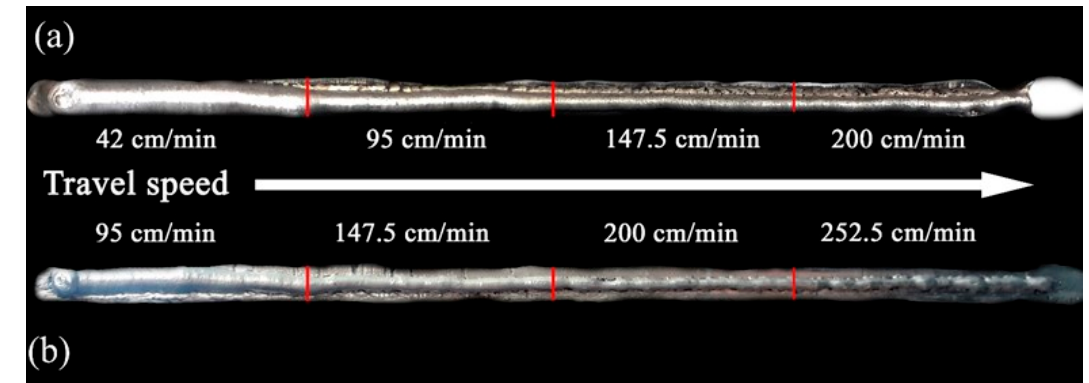
Figure 4. Top view of two substrates from the 1st stage of the experiments: ( a ) travel speeds from 42 to 200 cm/min; and ( b ) travel speeds from 95 to 252.5 cm/min (average current of 81 A and voltage of 12.5 V).